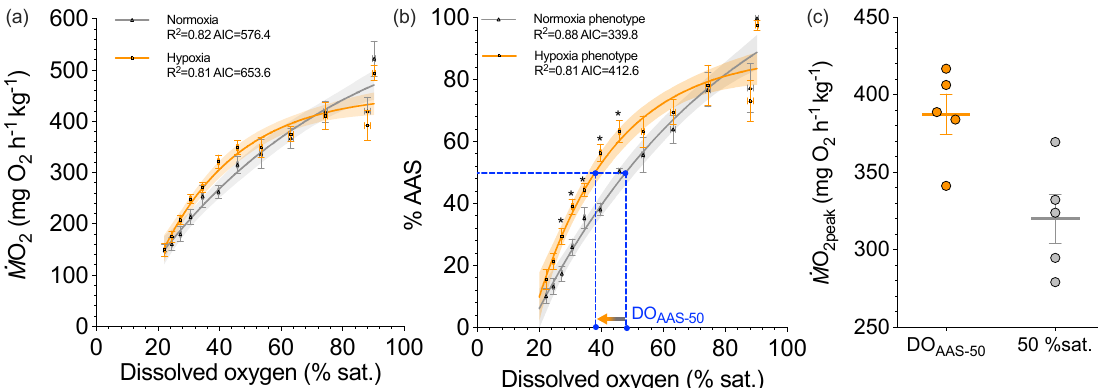
Figure 4. The limiting-oxygen (O 2 ) concentration performance curve of peak O 2 uptake ( ˙M O 2peak ) in normoxia- and hypoxia- acclimated juvenile European sea bass ( Dicentrarchus labrax ) at 16 ◦ C. ˙M O 2 values are measured ( a ) then normalized ( b ) as a percentage of absolute aerobic scope (% AAS) in each individual. Mean ± SEM for ˙M O 2 at a given dissolved O 2 in water in percentage air saturation (% sat.) was used to characterize a group HPC performance curve using one-phase association equations [normoxia phenotype of absolute ˙M O 2 : ( a ) normoxic phenotype: y = − 52.8 + (642.4 + 52.8) × [1 − e ( − 0.016 × X) ]; R 2 = 0.82, AIC = 576.4; hypoxic phenotype of absolute ˙ M O 2 : y = − 268.3 + (454.9 + 268.3) × [1 − e ( − 0.039 × X) ]; R 2 = 0.81, AIC = 653.6 ( b ) normoxic phenotype of normalized ˙M O 2 : y = − 39.5 + (130.0 + 39.5) × [1 − e ( − 0.005 × X) ]; R 2 = 0.88, AIC = 339.8; hypoxia phenotype of normalized ˙M O 2 : y = − 85.8 + (88.3 + 85.8) × [1 − e ( − 0.057 × X) ]; R 2 = 0.81, AIC = 412.6]. The solid curves are one-phase association regression models, and the shaded areas are the 95% confidence intervals of these curves. Asterisks denote the statistical significances between arcsine transformed % AAS between normoxia- and hypoxia-acclimated fish at each dissolved O 2 saturation (independent sample t -tests, α < 0.05). Blue dash lines illustrate the comparison of dissolved O 2 (DO) for 50% of AAS (DO AAS-50 ). The values of DO AAS-50 are labelled by the blue dots on the x-axis. ( c ) Scatterplots (mean ± SEM) for the comparisons of ˙M O 2peak measured at DO AAS-50 and ˙M O 2peak measured by one bout of 10 min chase inside the respirometer at 50% air saturation (% sat.). The figure and data are adapted from